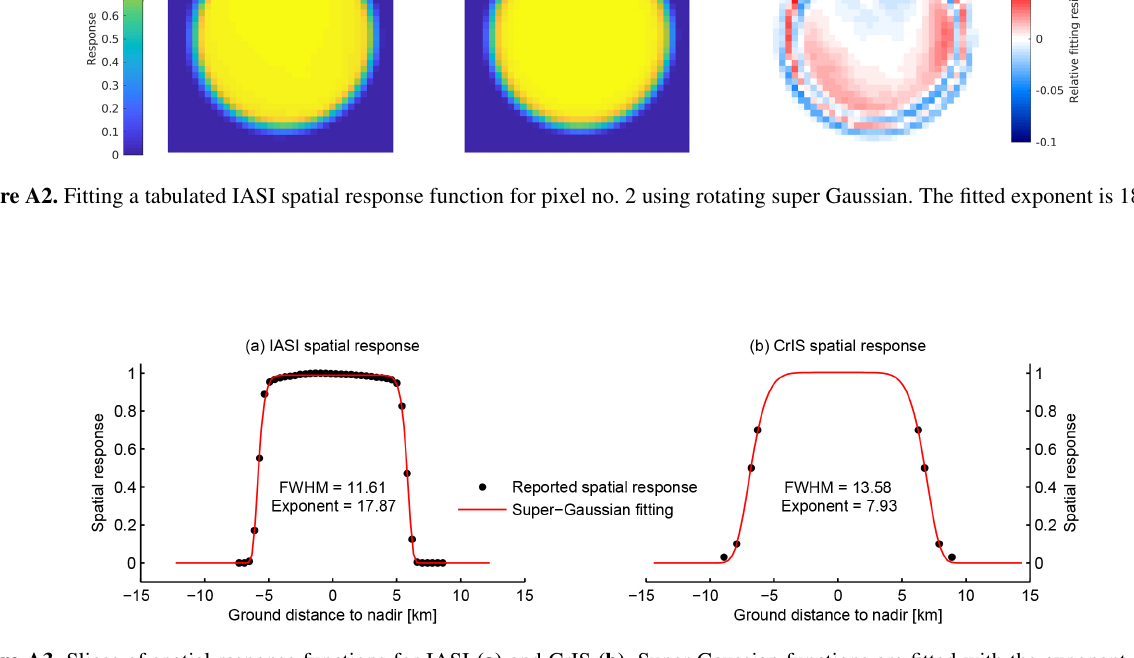
Figure A3. Slices of spatial response functions for IASI (a) and CrIS (b) . Super Gaussian functions are fitted with the exponent ∼ 18 for IASI and ∼ 8 for CrIS. The spatial response functions are projected on ground to reflect actual nadir pixel